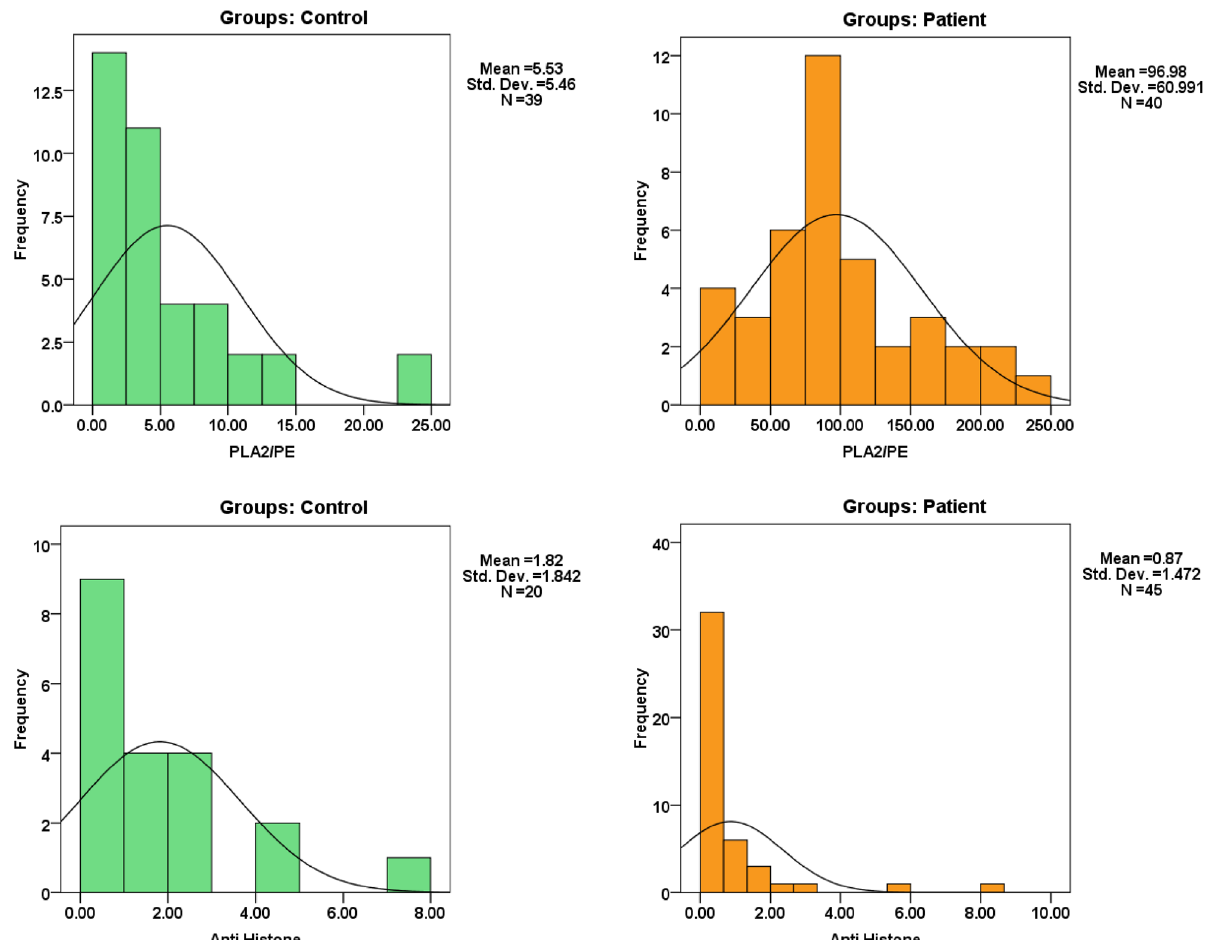
Figure 1. Data distribution of anti-histone autoantibodies and PLA2/PE relative ratio in control and ASD patients.